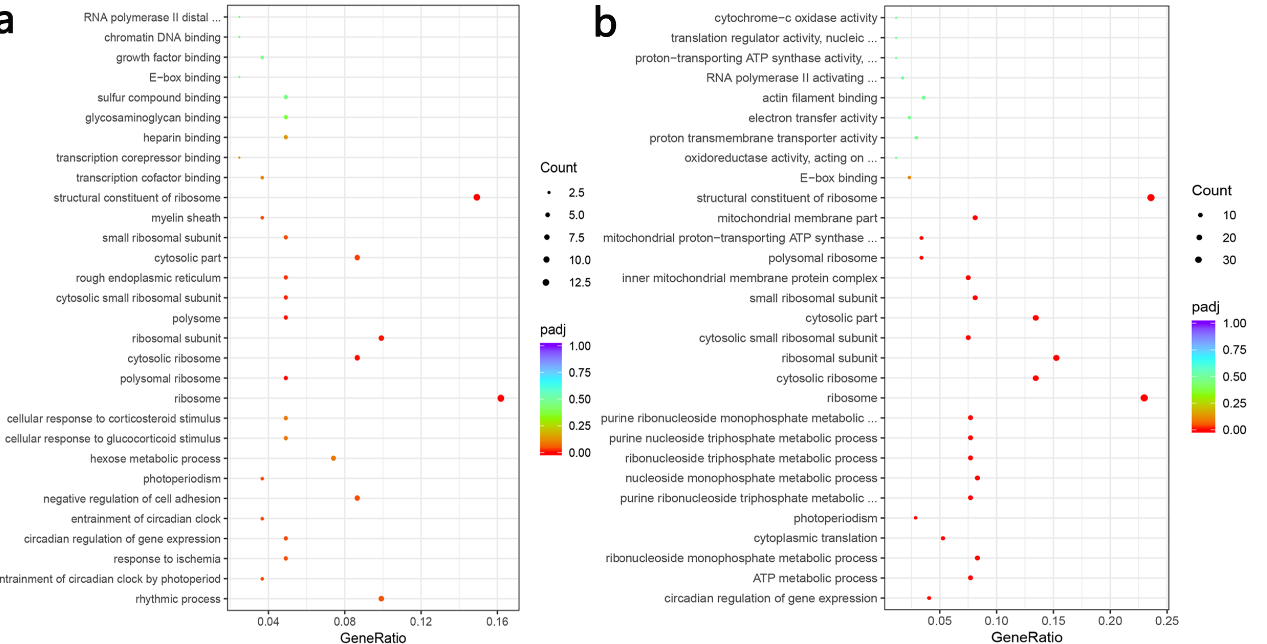
Figure 7. Gene ontology functional enrichment. Gene ontology functional enrichment of all DEGs in LN + SR37 ‐ 3 vs. LN ( a ) and LN + SR61 ‐ 2 vs. LN ( b ). cont LN: L ‐ NAME treated rats receiving standard chow; LN + SR37 ‐ 3: L ‐ NAME treated rats receiving PFM ‐ SR37 ‐ 3; LN + SR61 ‐ 2: L ‐ NAME treated rats receiving PFM ‐ SR61 ‐ 2.